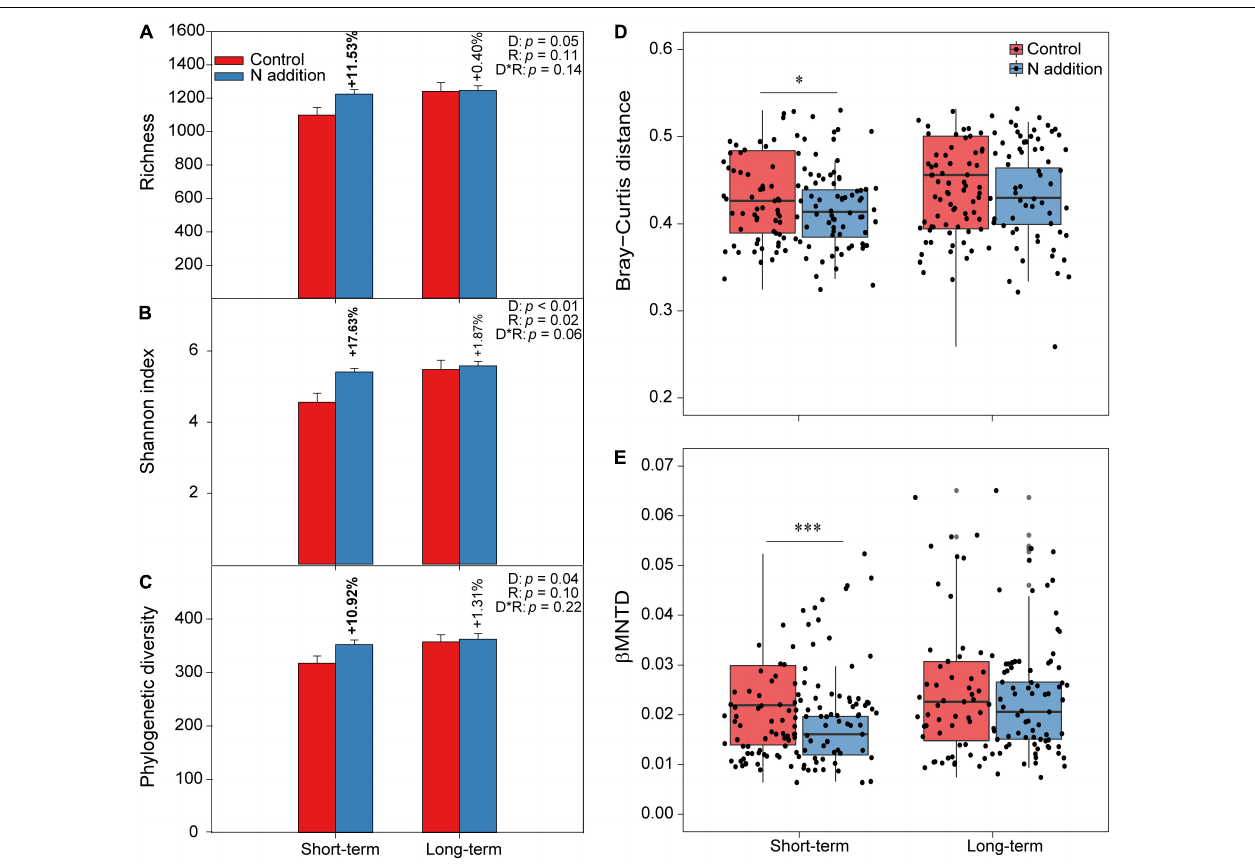
FIGURE 2 | The varations of fungal α -diversity and community composition under short- and long-term N additions. (A–C) The varaitions of fungal α -diversity under N addition are indicated by Student’s t -test at the short- and long-term sites, respectively. The bold numbers denote the significantly differences ( p < 0.05) of fungal α -diversity between control and N addition at each site. The insert texts indicate the effects of duration (D), rate (R) of N addition, and their interactions on fungal α -diversity detected by two-way ANOVA. (D,E) The boxplots show community dissimilarities between control and N addition at the short- and long-term sites based on Bray–Curtis distance and β MNTD, respectively ( ∗ p < 0.05; ∗∗∗ p < 0.001; Wilcoxon rank-sum